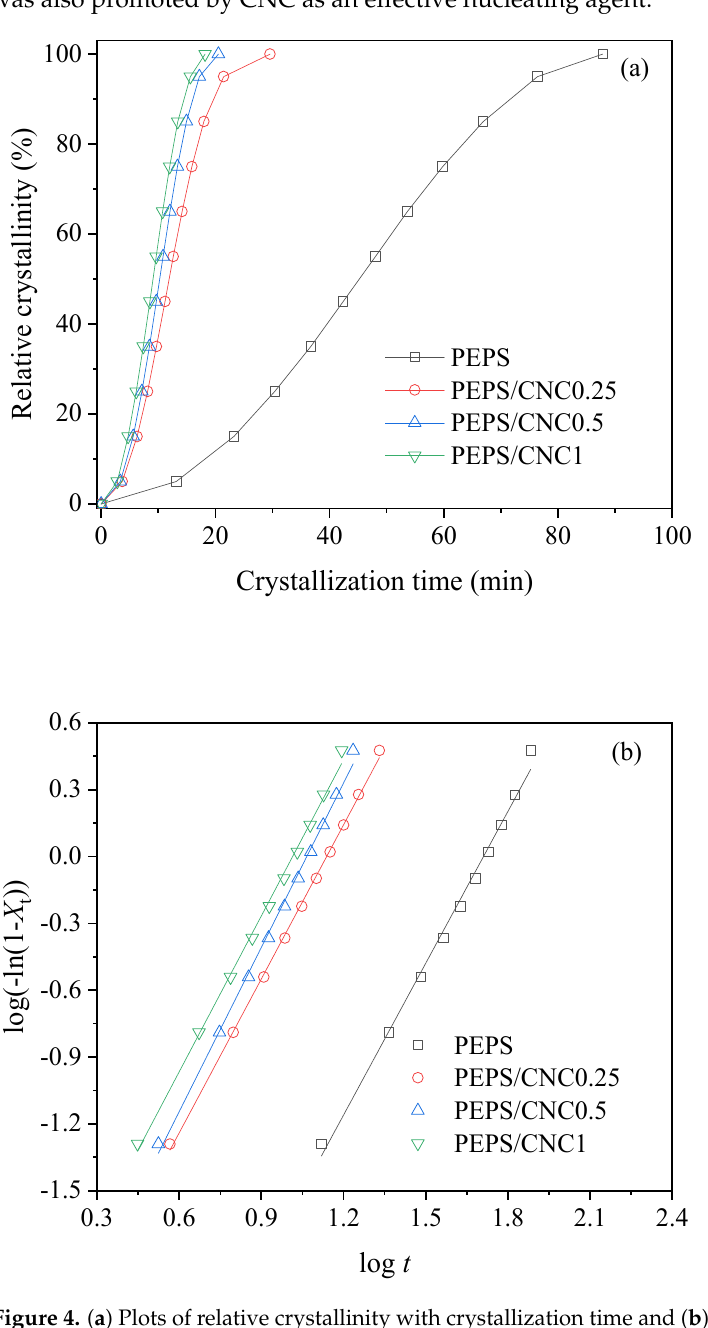
Figure 4. ( a ) Plots of relative crystallinity with crystallization time and ( b ) Avrami plots for PEPS and PEPS/CNC composites at 71 °C.